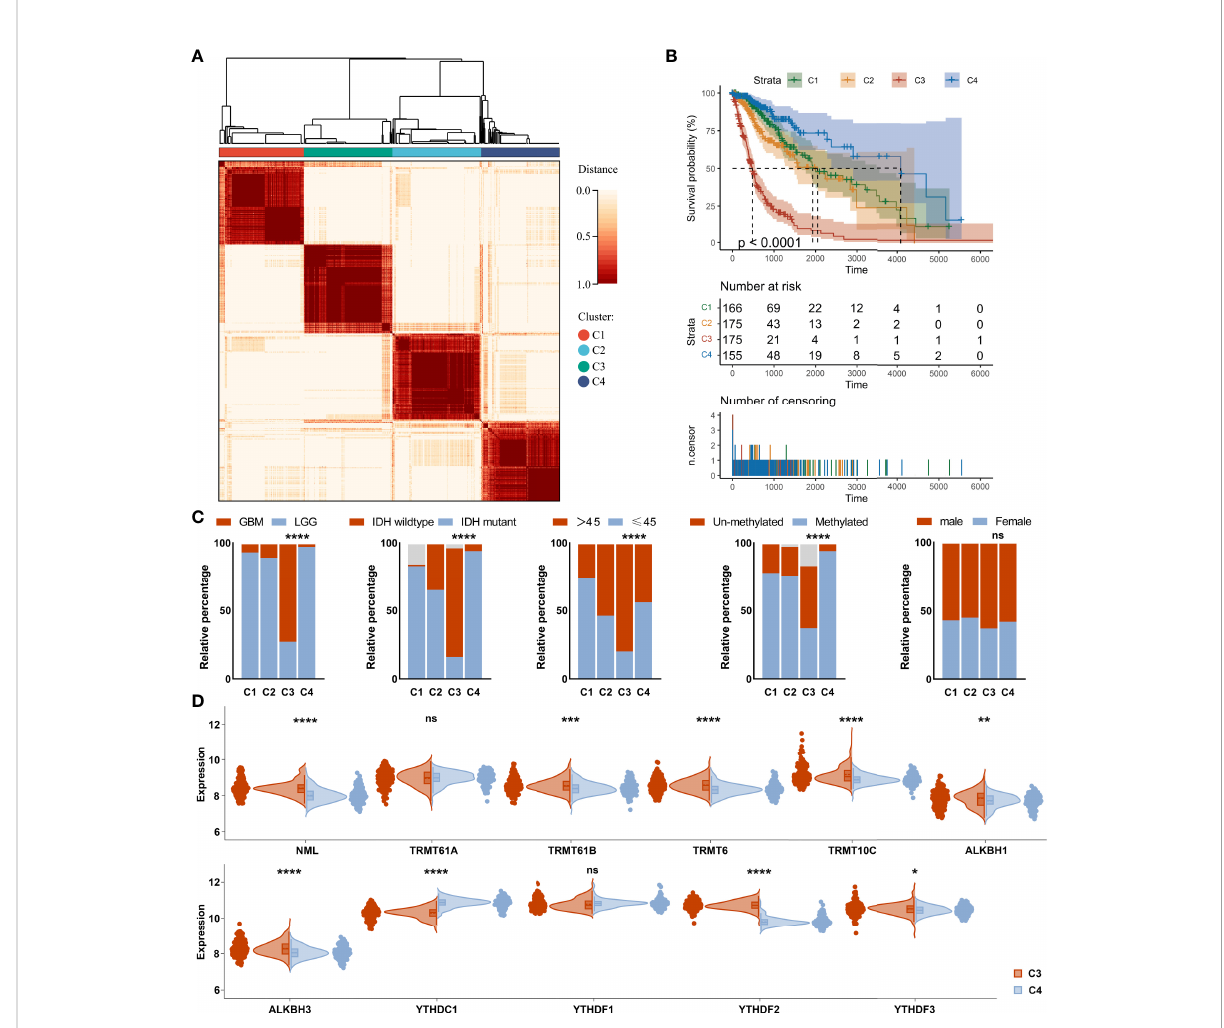
FIGURE 3 Consensus clustering analysis of m 1 A regulators in glioma. (A) Consensus clustering matrix for the most suitable k = 4. (B) Kaplan-Meier curves displaying prognostic differences between different clusters. (C) Differences in clinical phenotypes between different clusters. (D) Differences in expression of m 1 A regulators between cluster 3 and cluster 4. ns, no signi fi cance; *, P< 0.05; **, P< 0.01; ***, P< 0.001; ****, P<